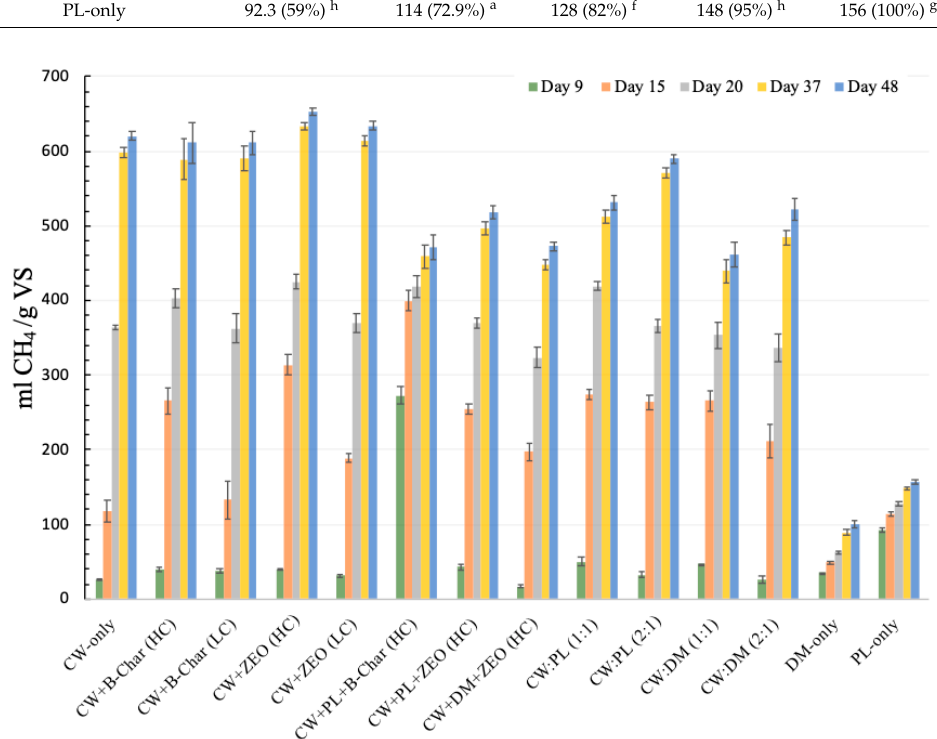
Figure 2. Cumulative methane (CH 4 ) production based on volatile solids (VS) added to each reactor for cassava wastewater (CW) digested alone and co-digested with poultry litter (PL), dairy manure (DM), zeolite (ZEO), and biochar (B-Char) at low and high concentrations (LC and HC) at five time points (Days 9, 15, 20, 37, and 48) in the 48-day digestion